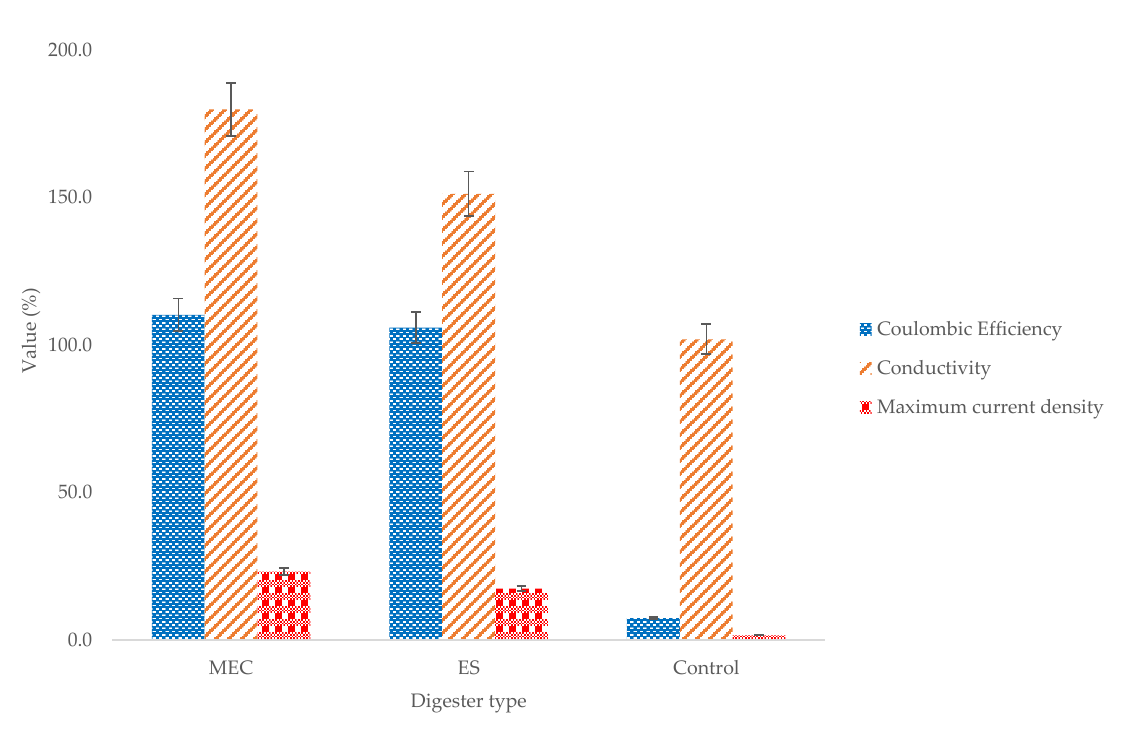
Figure 7. Coulombic efficiency, electrical conductivity, and maximum current density with respect to digester type.